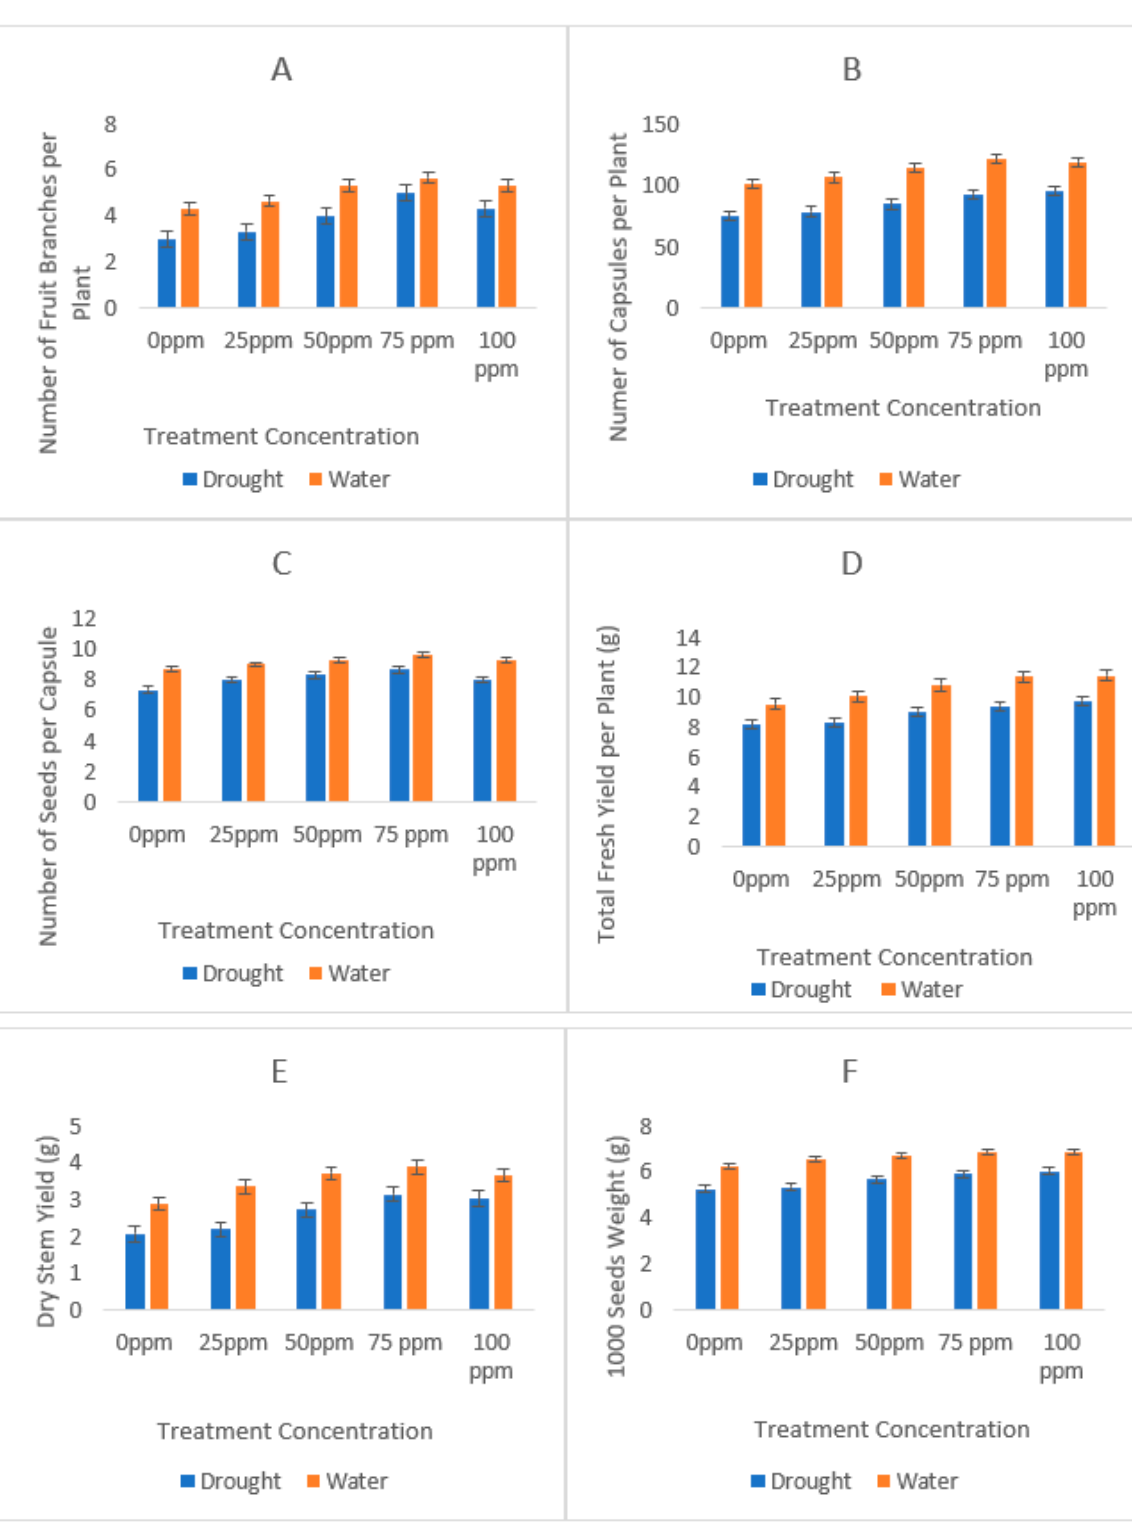
Figure 3. Yield attributes of rice plants. ( A ) Number of fruit branches per plant. ( B ) Number of cap- sules per plant. ( C ) Number of seeds per capsule. ( D ) Total fresh yield. ( E ) Dry stem yield. ( F ) 1000 seeds weight. As influenced by various levels of IONPs under water-scarce and well-irrigated en- vironment (mean ± SE; n = 3).